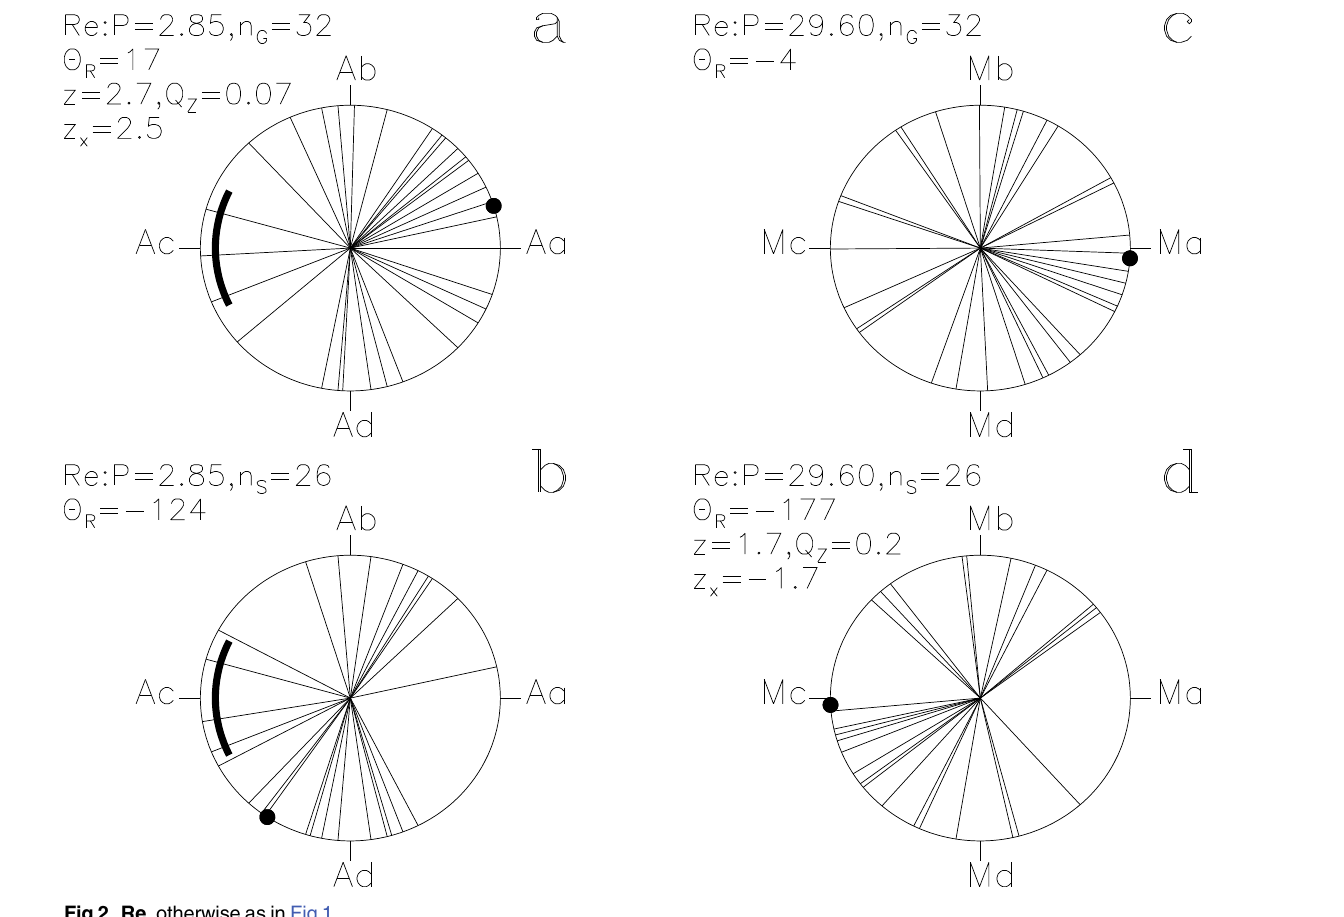
Fig 2. Re. otherwise as in Fig